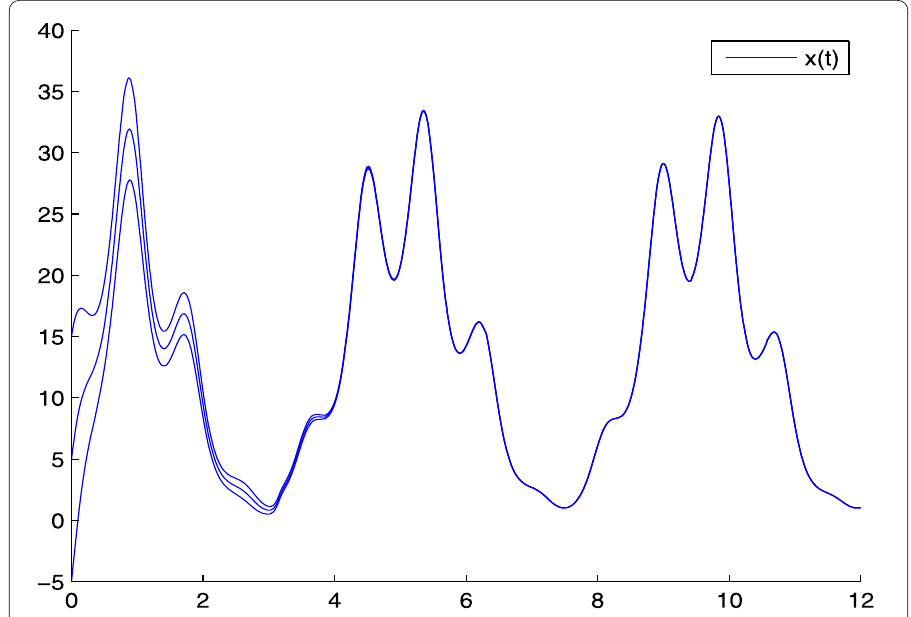
Figure 1 Numerical solutions x ( t ) of system (4.1) for initial value ϕ ( s ) = 15,5,–5, respectively, where s ∈ [–6,0]